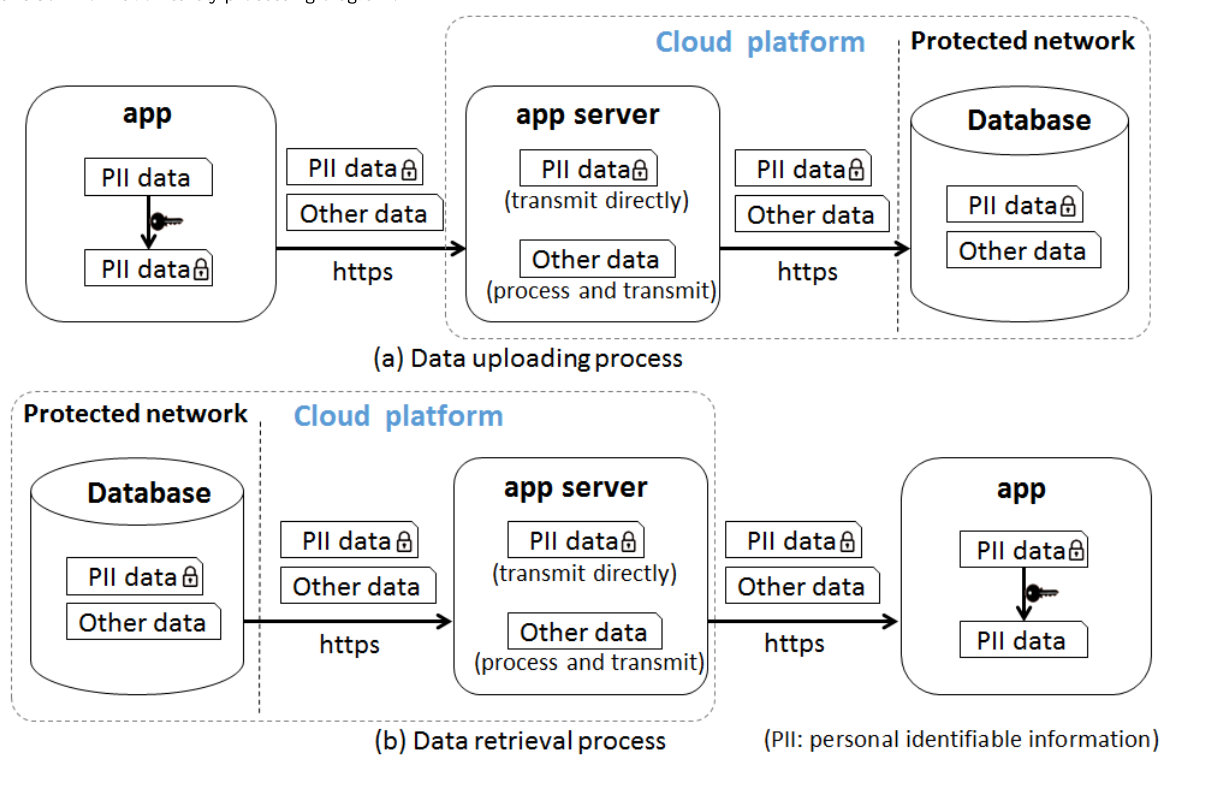
Figure 3. Information safety processing